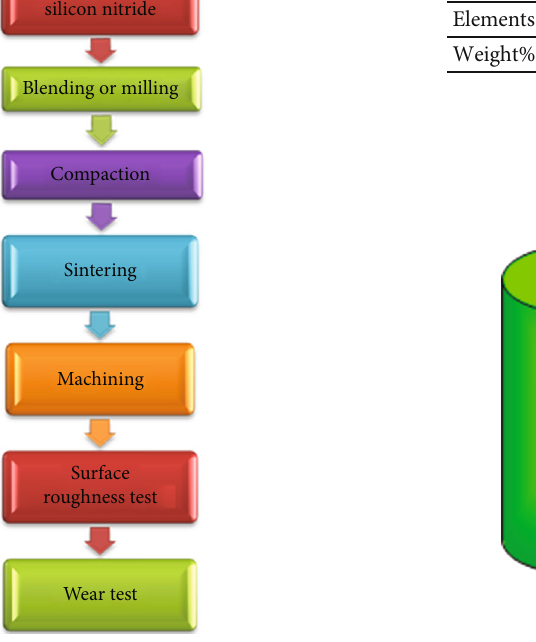
Figure 2: Punch and die for the compaction. Table 2: Sintering process sequence.